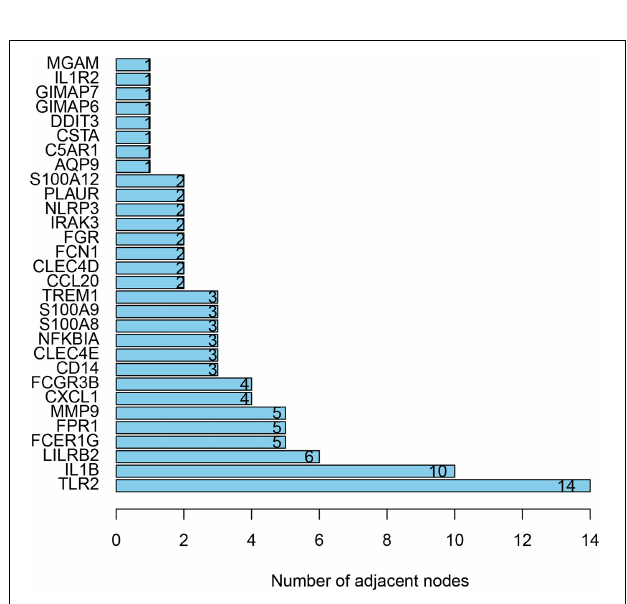
FIGURE 7 | The number of adjacent